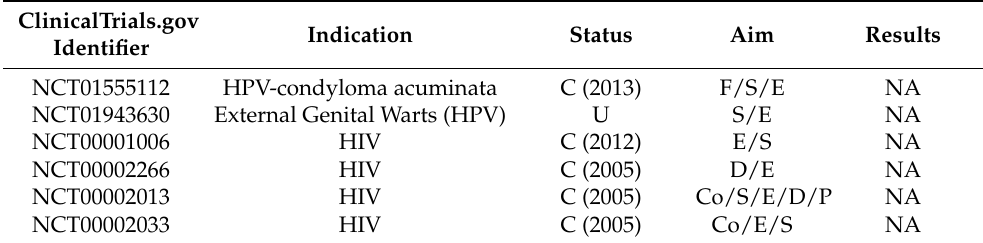
Table 4. Clinical trials involving AS101 as anti-infective agents (from https://clinicaltrials.gov/, accessed on 27 April